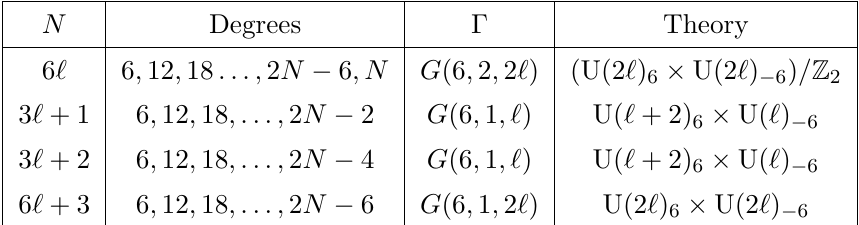
Table 17 . Theories obtained by compactifying so (2 N ) SYM via a twist by N 6 R 6 . The result depends on the value of N modulo 6. In all cases we obtain theories of ABJ